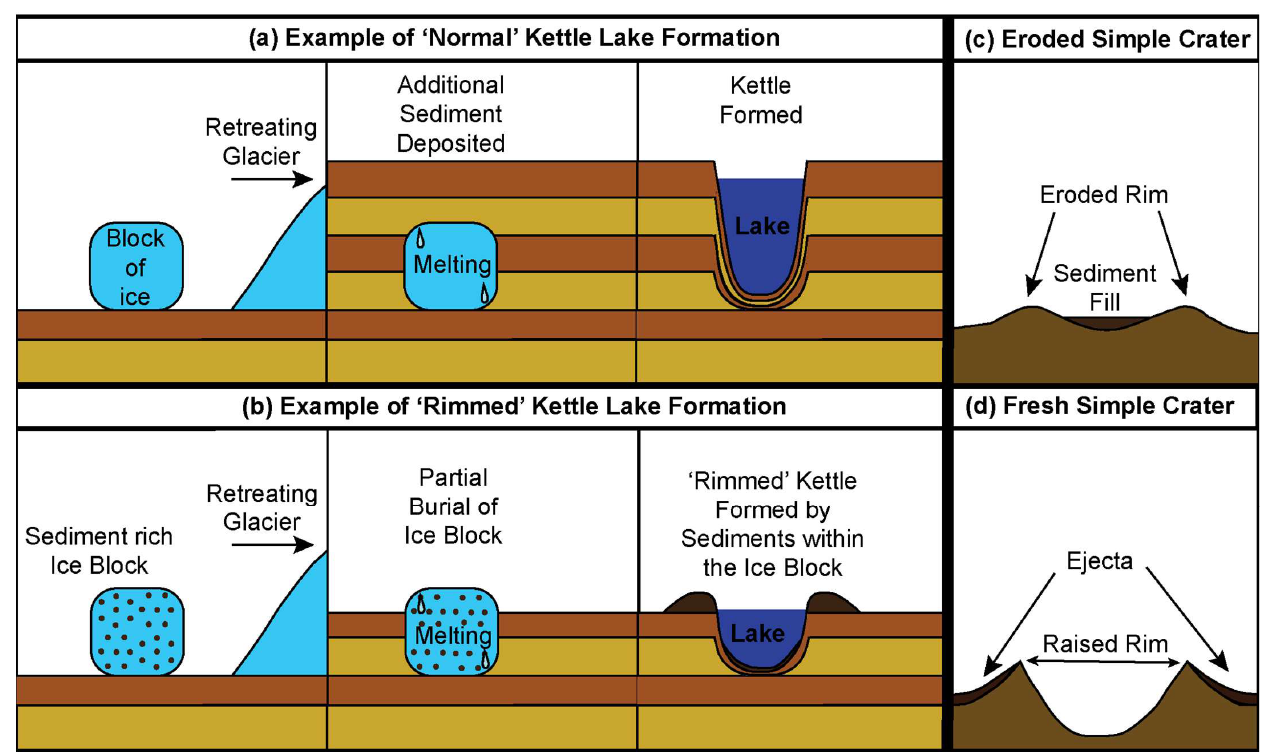
Figure 1. Schematic comparison between kettle holes and craters. ( a , b ) Kettle hole formation. Kettle holes form when blocks of ice left behind by a retreating glacier are buried by sediment (brown and yellow layers), and then melt. The ice may be entirely ( a ) or partially ( b ) buried and may contain little ( a ) or significant ( b ) sediment in the block interior. When the ice block melts, the surrounding and overlying sediment collapses, forming a local pit that is often filled with water. In cases where sediment was contained within the block of ice, a raised rim may form around the margins of the kettle hole or lake ( b ). Craters also form local depressions of a similar scale to kettle holes ( c , d ). Simple craters (as opposed to complex craters with central uplift peaks, not shown) form depressions with respect to the surrounding topography and have raised rims ( d ). These rims may become degraded (more rounded, lower relief) over time, and sediment infilling of the crater can change the depth-to-diameter ratio and give the crater a flat floor ( c ). The formation mechanisms of craters and kettle holes are distinct, but significant morphological overlap exists between the two resulting features.